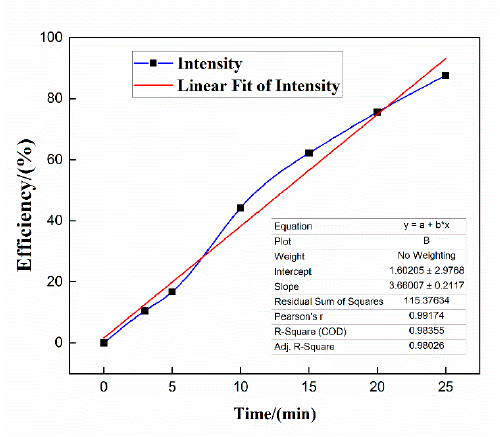
Figure 11. Fitting curve of cleaning efficiency.